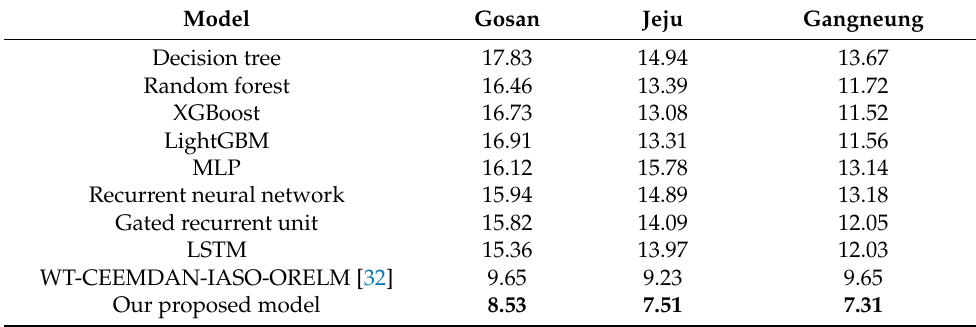
Table 5. NRMSE results of solar radiation forecasting models in three regions (%).